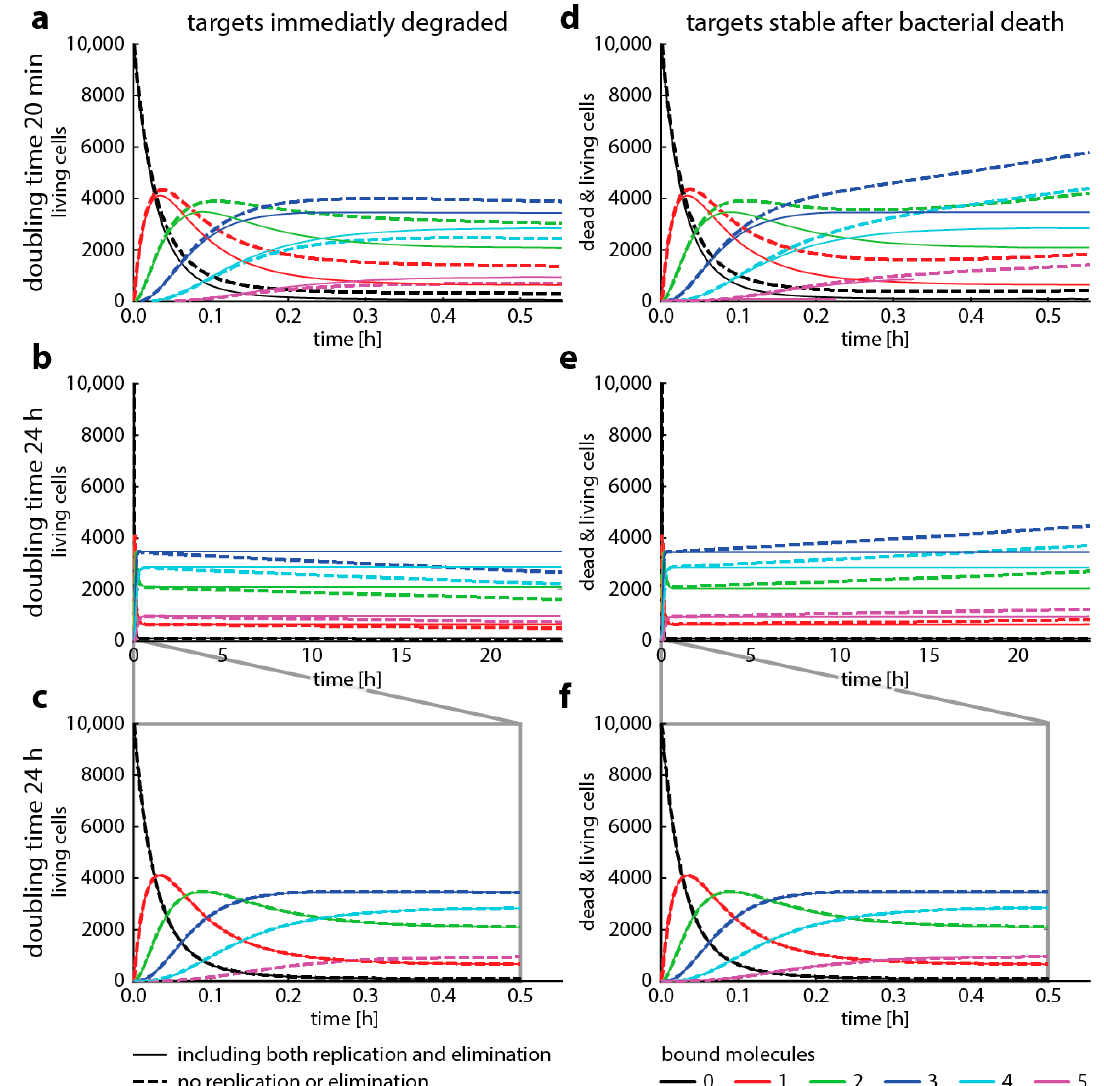
Figure A1. Bacterial replication changes target occupancy. This graph shows simulations of the same parameter sets as in Figure 4, but with different assumptions about how target occupancy changes bacterial replication. In Figure 4, we assume that the replication rate depending on target occupancy is a step function where replication suddenly ceases when more than two target molecules are bound. In this figure, we assume that the replication rate depends linearly on target occupancy. As in Figure 4, this graph shows how target occupancy with replication and death (dashed lines) changes compared to target occupancy without replication or death (solid lines) for two different cases where the drug targets are immediately degraded after bacterial death (left column) or remain stable after bacterial death (right column). All parameters are the same as in Figure 3 with added replication. We assume that replication immediately ceases when more than two target molecules are bound and that cell die immediately when there are at least four bound target molecules. The doubling time ( ln replication rate (cid:3039)(cid:3041)((cid:2870)) ) is either 20 min (top panel) or 24 h (mid and bottom panels). The bottom panel highlights the first 30 min of the mid panel time course. The death rate is always 2x the replication rate. ( a – c ) show the number of living bacteria only, ( d – f ) show both living and dead cells.